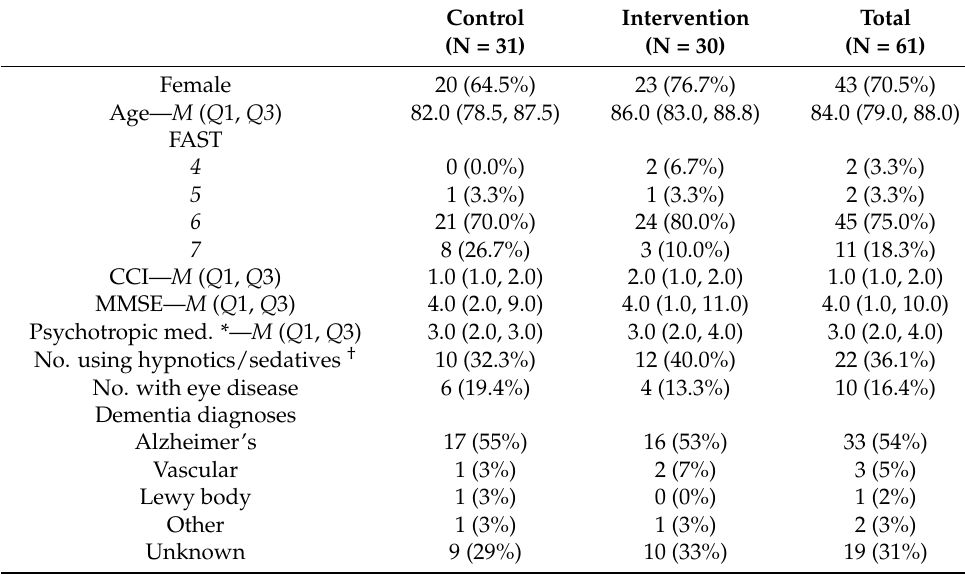
Table 2. Baseline descriptive statistics.